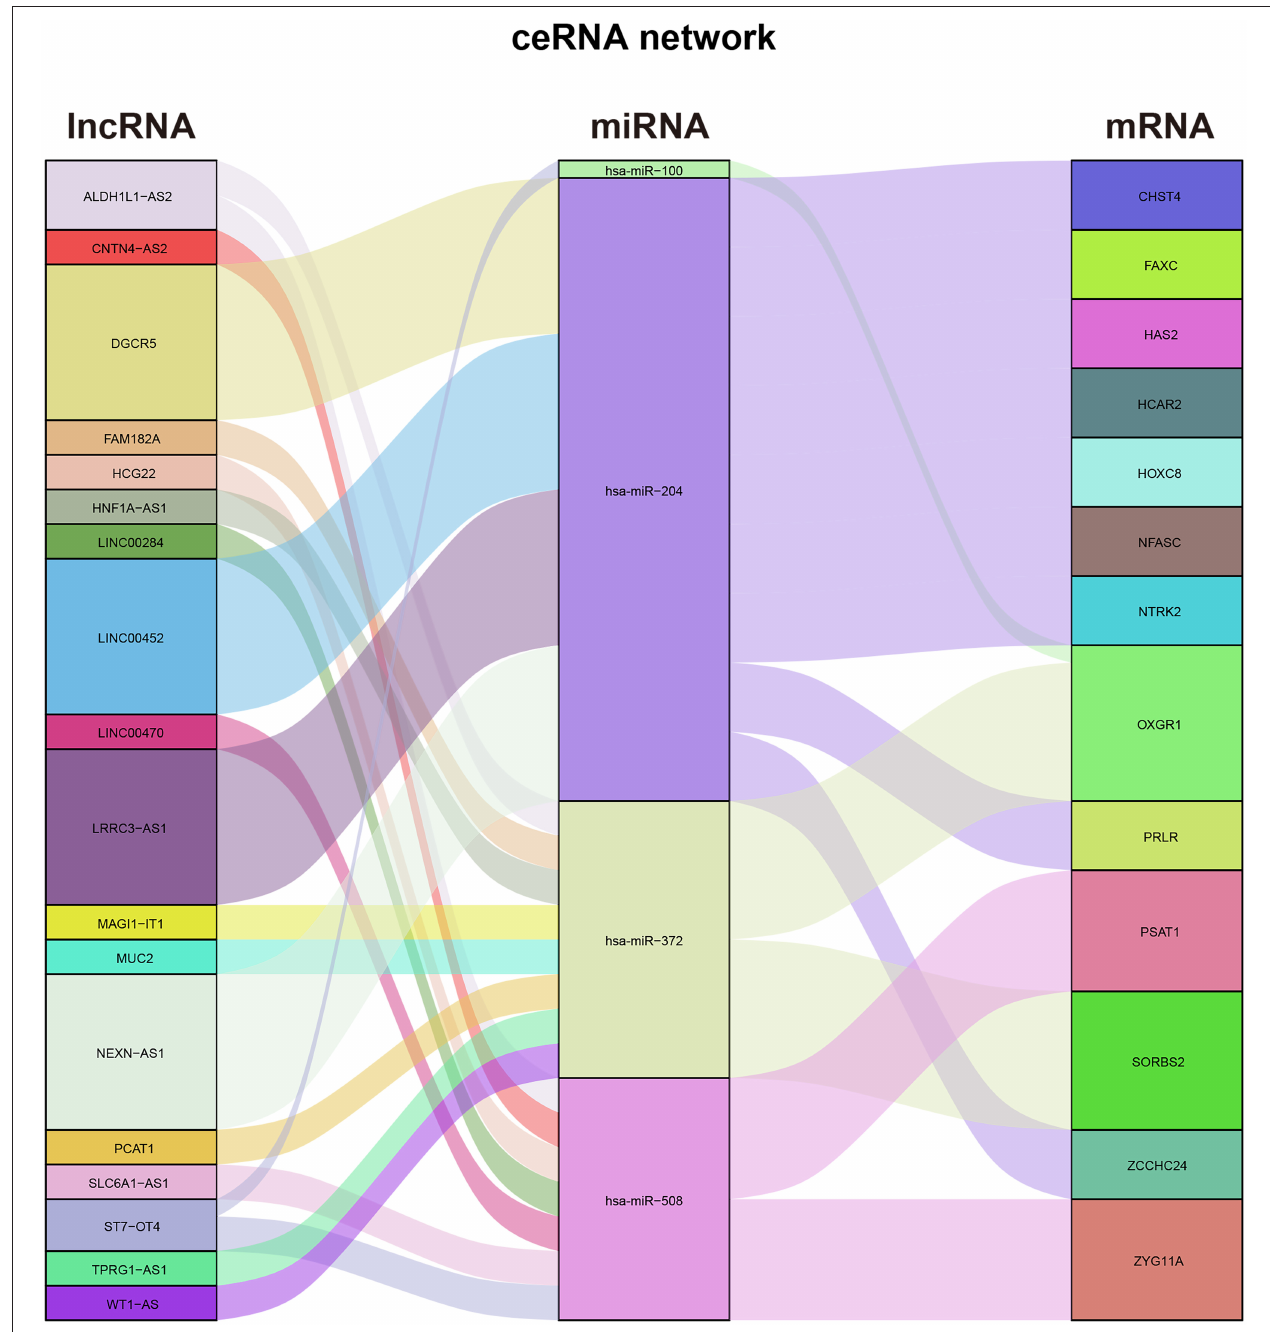
FIGURE 3 | Alluvial plot of the ceRNA network in patients with